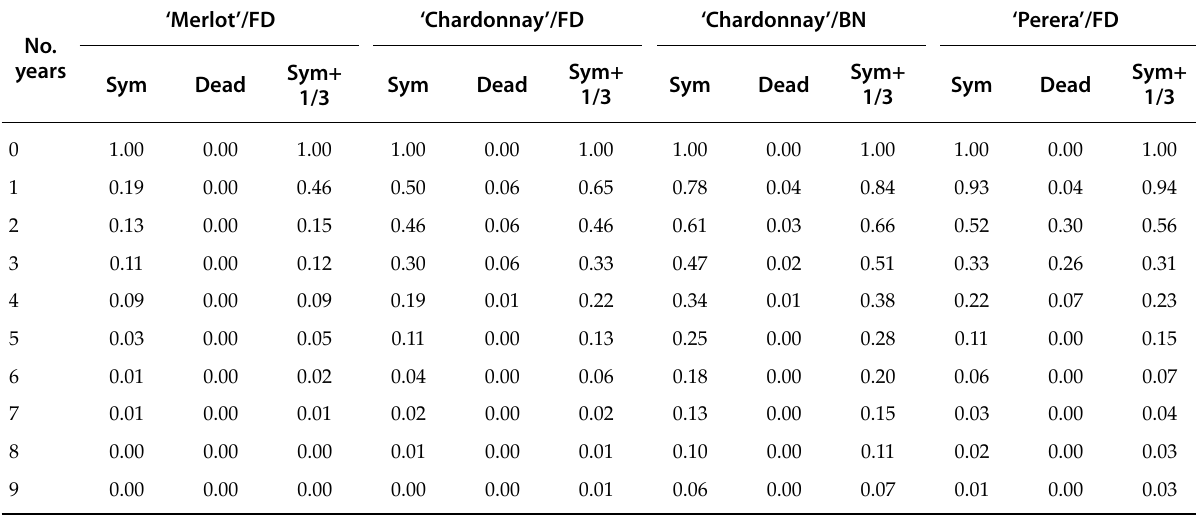
Table 3. Proportion of symptomatic and dead grapevine plants from the year of the first manifestation of the symptoms. For FD after the 7th year the data were extrapolated on the basis of the trend. N. = 0 is the year of the first manifestation of symptoms; Sym = symptomatic grapevines; Dead = dead grapevines; Sym+1/3 = symptomatic grapevines increased by a third of recovered grapevines.